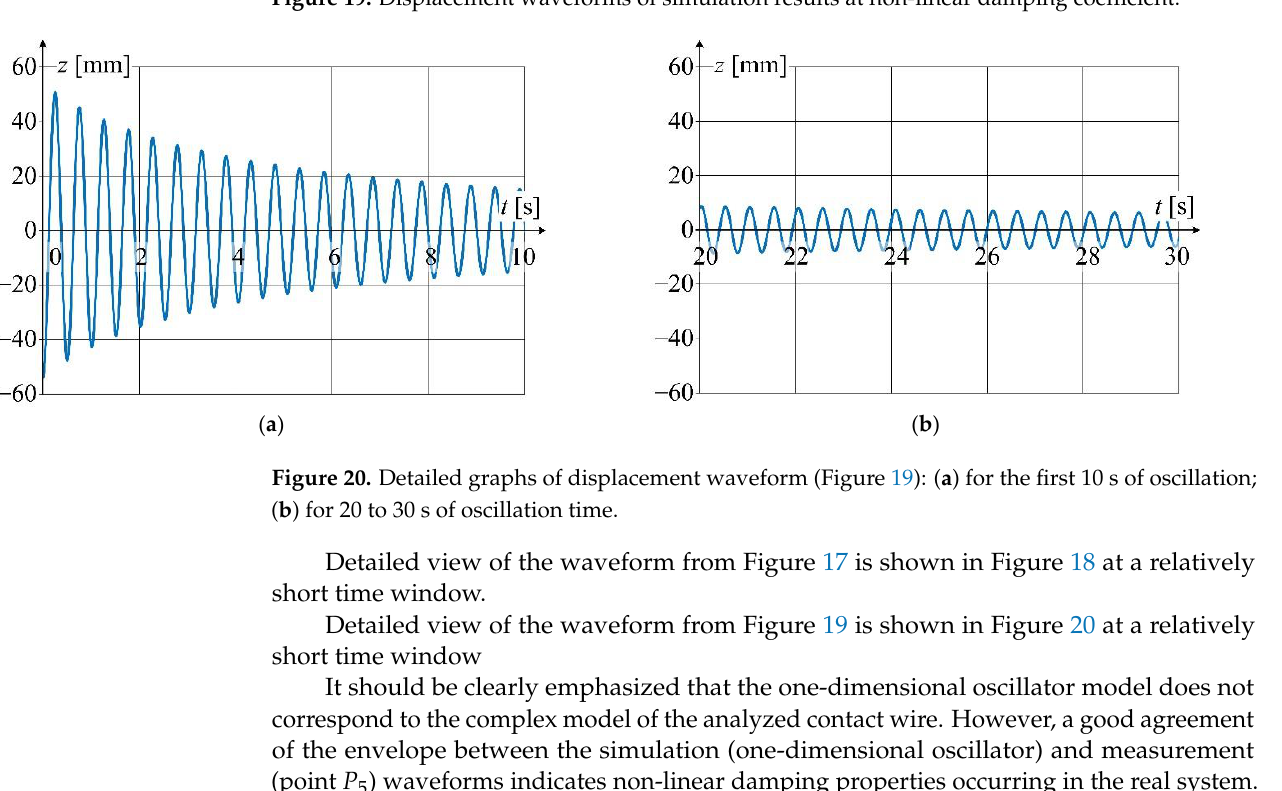
Figure 18. Detailed graphs of displacement waveform (Figure 17): ( a ) for the first 10 s of oscillation;